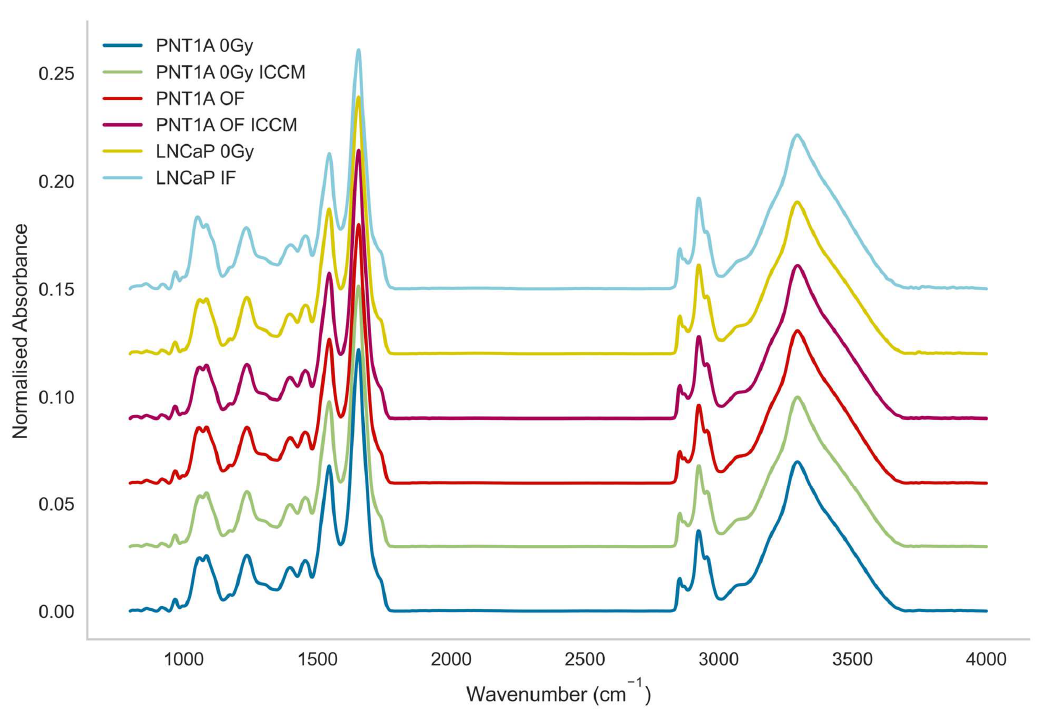
Figure 1. Mean spectra of all cell lines by class. Visualisation of the principal component scores was conducted with a separate de- composition applied to spectra from the PNT1A line and the LNCaP line, together with each of their treated spectra (Figure 2). Here, again it is not possible to visually separate each of the cell lines, nor their treatment classes using this approach.